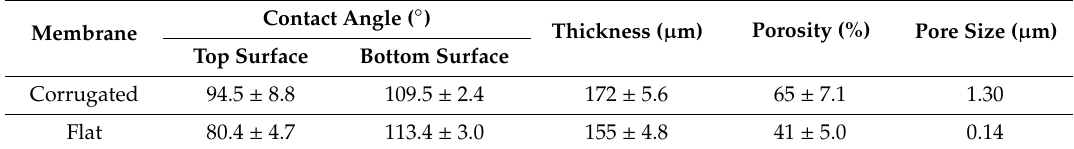
Table 2. The properties of the developed PVDF